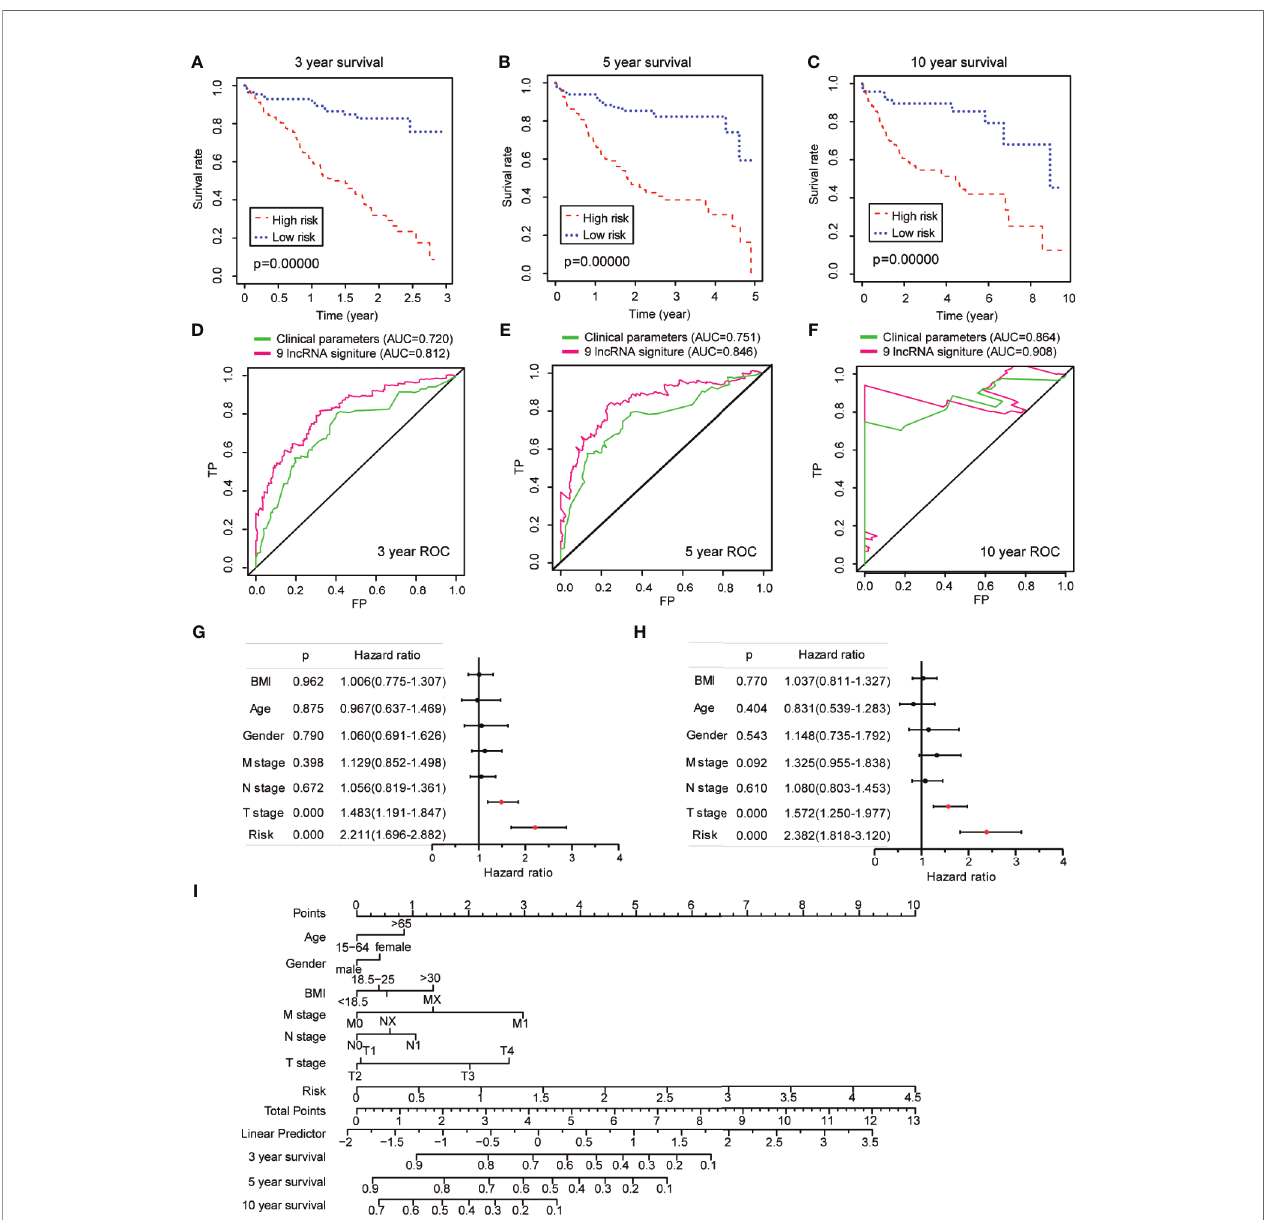
FIGURE 5 | Prognostic value of ferroptosis-associated lncRNA signature in The Cancer Genome Atlas – hepatocellular carcinoma cohort. (A – C) Kaplan – Meier analyses for the prognostic prediction of risk score model at 3-, 5-, and 10-year survival time, respectively. (D – F) Time-dependent receiver operating characteristic curves for the prognostic prediction of risk score model at 3-, 5-, and 10-year survival times, respectively. (G, H) Univariate and multivariate Cox regression analyses for the risk score model as an independent prognostic factor. (I) A combined nomogram for the risk score model and other clinicopathological